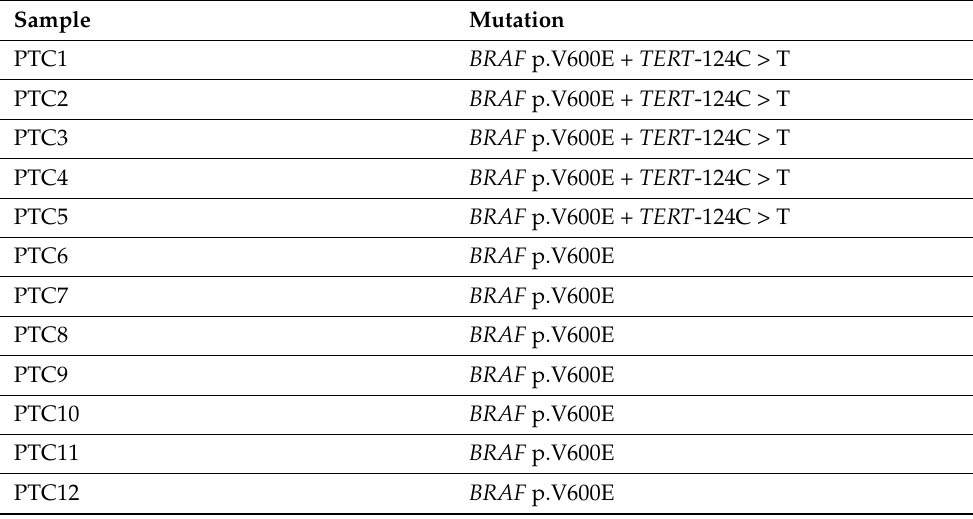
Figure 1. ( A ) H 2 O 2 generation in thyroid tissues. The median value was plotted; ( B ) Paired analysis of H 2 O 2 generation in tumors and corresponding normal tissues. N = normal contralateral tissue; FA = follicular adenoma; HA = Hurtle cell adenoma; PTC = papillary thyroid carcinoma; NIFTP = non-invasive follicular thyroid neoplasms with papillary-like nuclear features; FTC = follicular thyroid carcinoma; PDTC/ATC = poorly differentiated thyroid cancer/anaplastic thyroid cancer. Table 2. Mutational profiles of thyroid